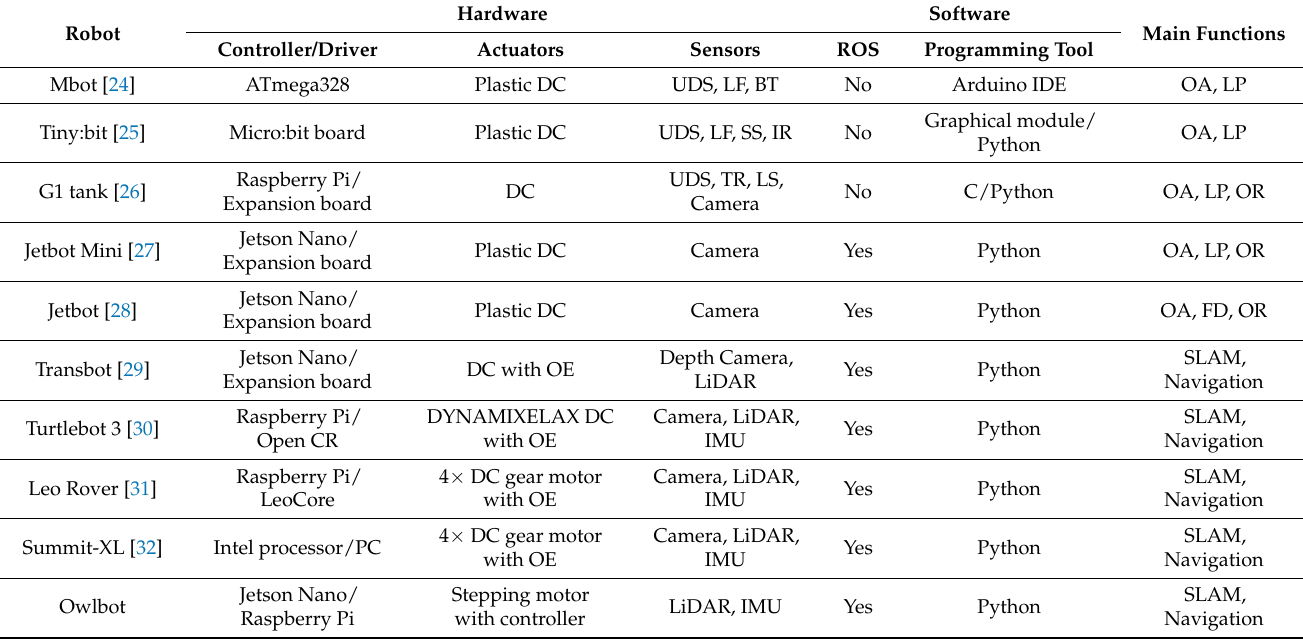
Table 1. Software, hardware, and main functions of different robot